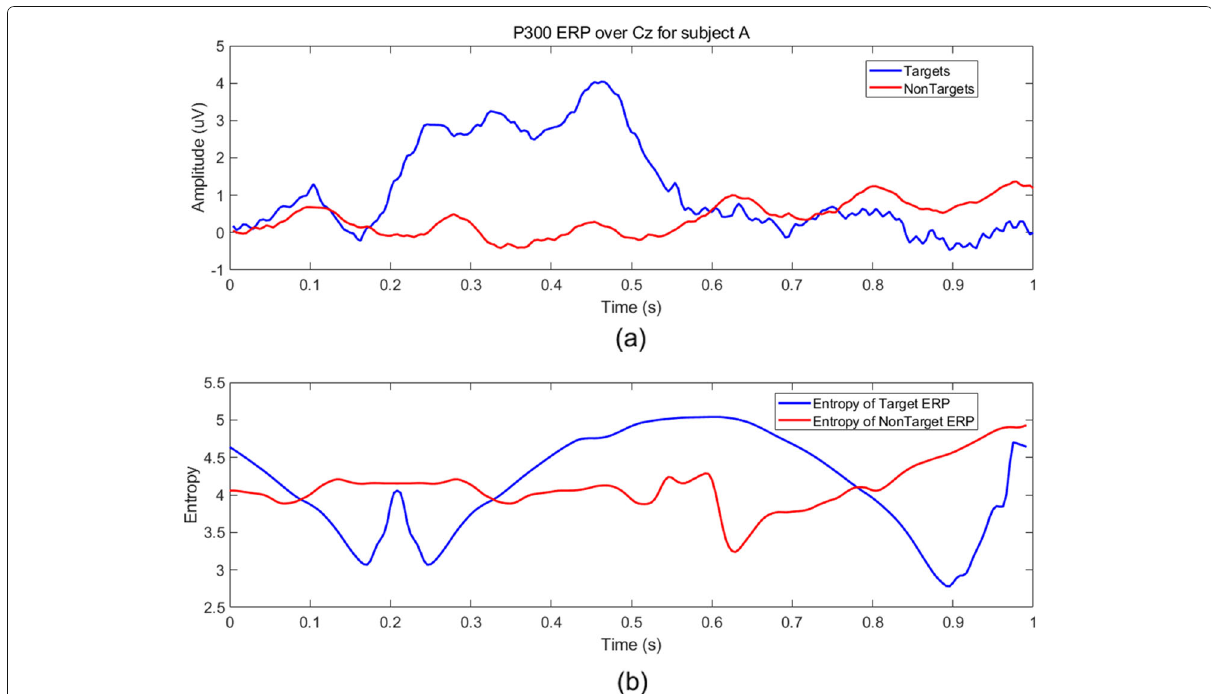
Fig. 13 Visual P300 experiment recorded at electrode Cz for subject A. a Trial average ERPs of targets and non-targets. b Short-term Rényi entropy of averaged ERPs